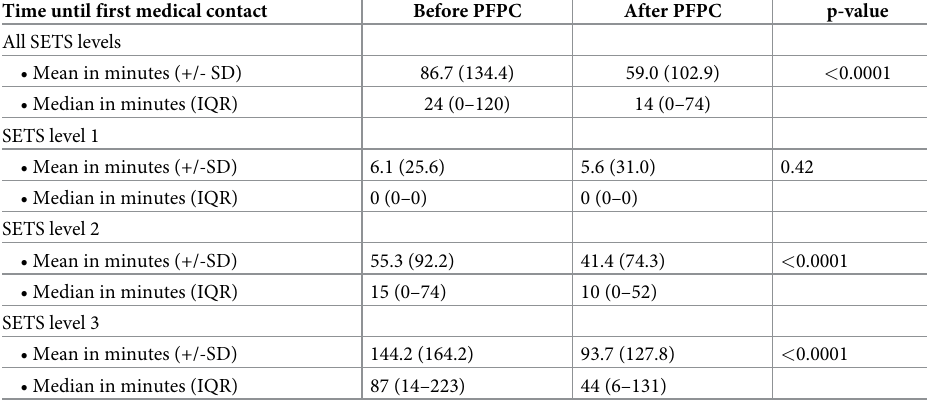
Table 3. Waiting times until first medical contact, before and after introducing patient-flow physician coordinator. Time until first medical contact Before PFPC After PFPC p-value All SETS levels